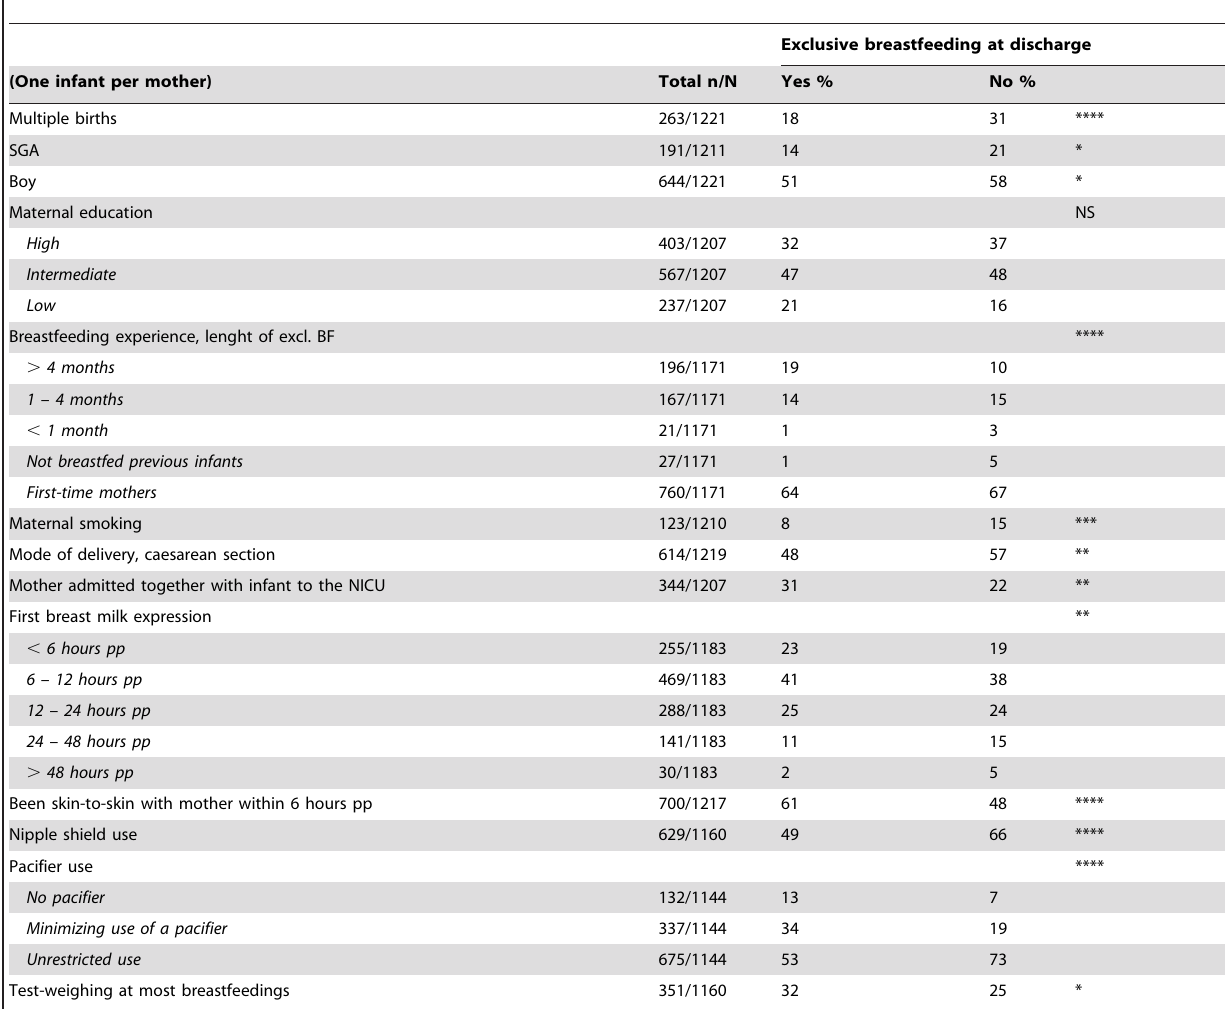
Table 2. Proportions of infant and mother characteristics and clinical practices in exclusive and non-exclusive breastfeeding